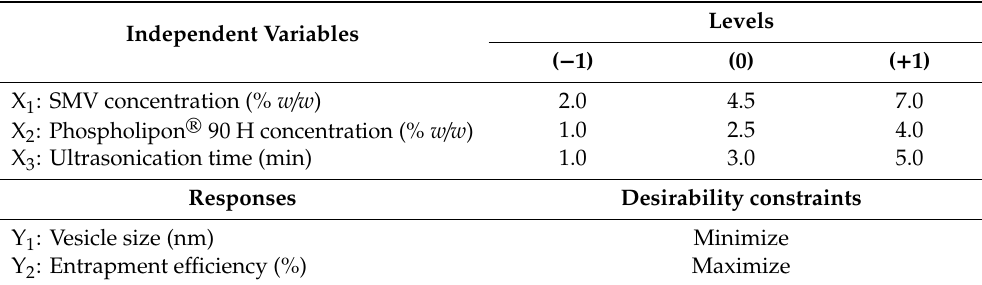
Table 1. Independent variables and responses used in the Box–Behnken design for the formulation and optimization